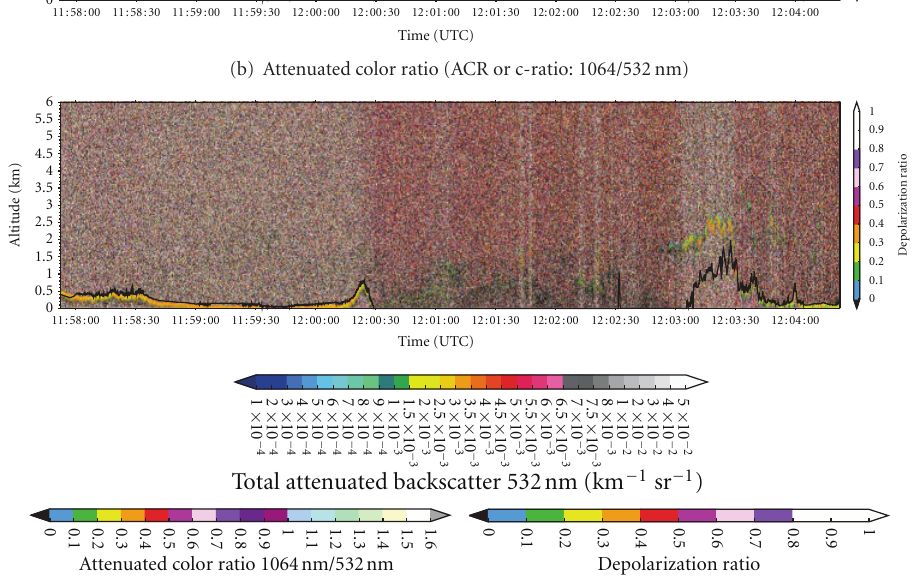
Figure 7: Same as in Figure 6, but for the CALIPSO day-time overpass on 5